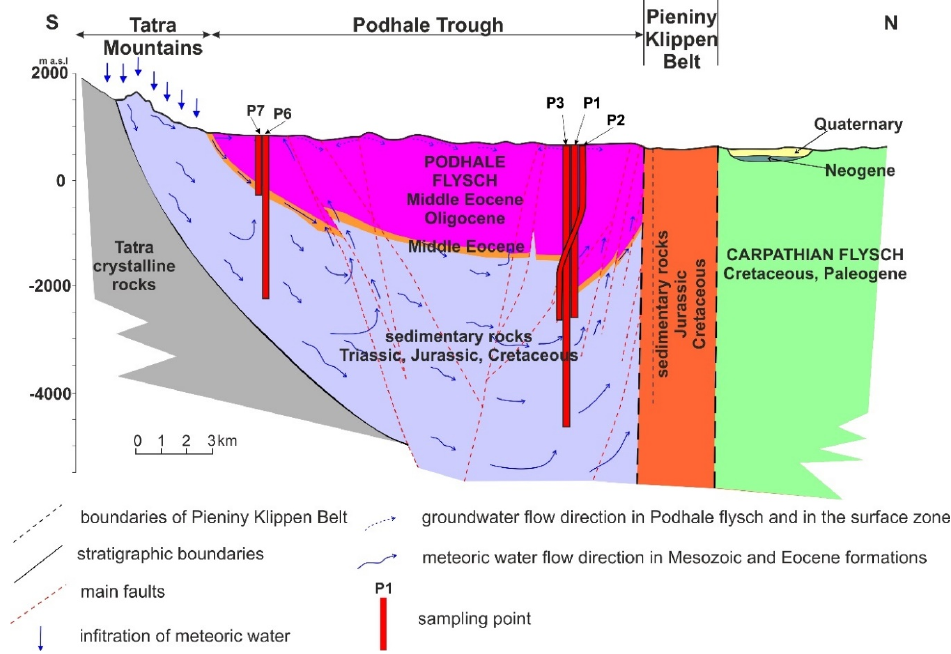
Figure 2. Hydrogeological cross-section through the Podhale Trough ([32,37,45] modified). Samples of thermal water were collected according to ISO 5667-11 standards [46] in July